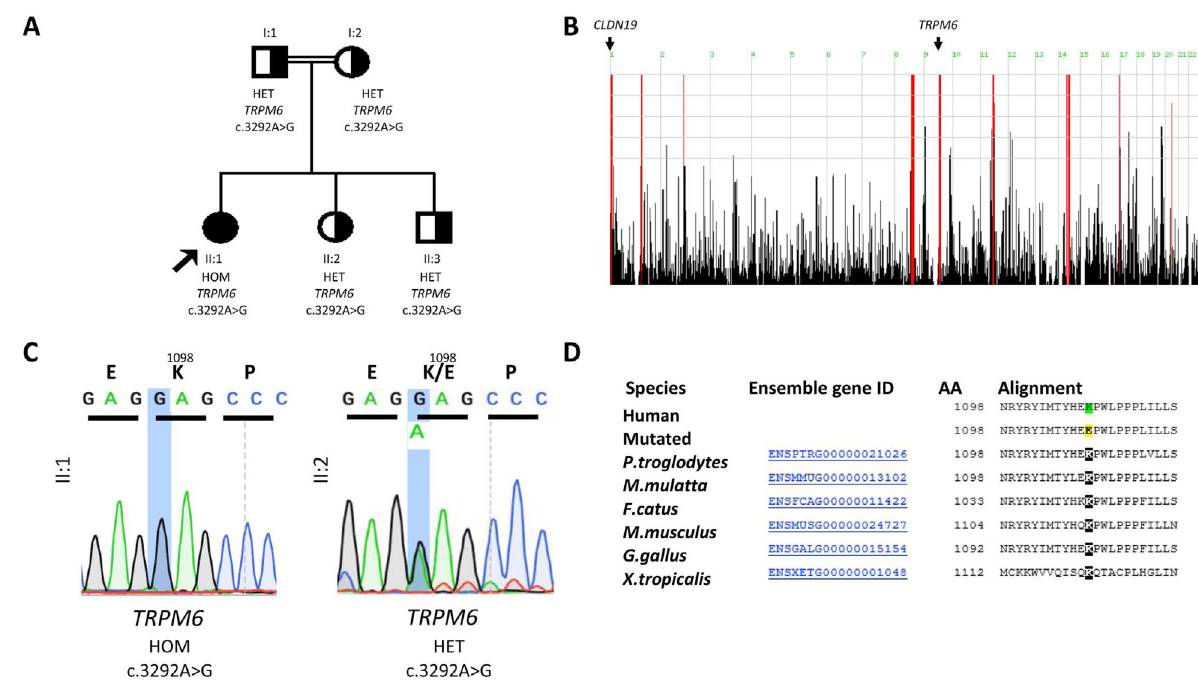
Figure 1. Identification of TRPM6 missense mutation as the cause of familial hypomagnesaemia. ( A ) Pedigree diagram showing proband (arrowed) who is homozygous for c.3292A>G p.(K1098E) missense mutation in TRPM6 and segregation of alleles from each parent. Parents were consanguineous (second cousins). ( B ) Homozygosity mapping across chromosomes 1-22. Red bars indicate regions of homozygosity. Candidate genes CLDN19 and TRPM6 (arrowed) are located within regions of homozygosity. ( C ) Chromatograms from proband (II:1) and sibling (II:2) showing TRMP6 variant in homozygous and heterozygous state, respectively. ( D ) Amino acid (AA) alignment showing conservation of the K1098 residue of TRPM6